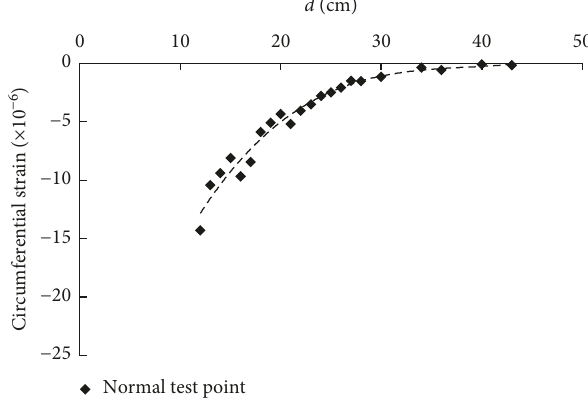
Figure 10: The test result of circumferential strain on the top of the AC pavement structure model.